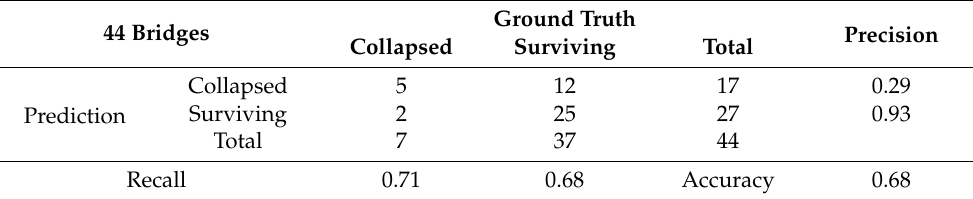
Table 5. Confusion matrix of the validation set using the RF model with three input features.